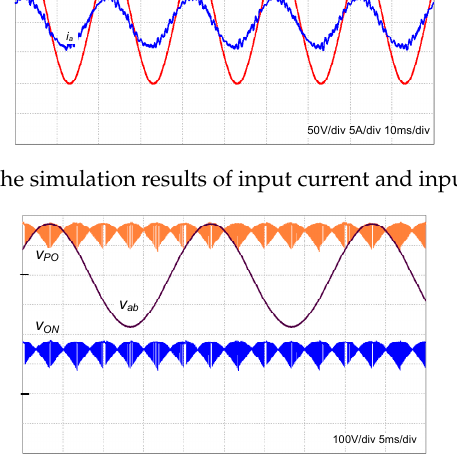
Figure 9. The simulation results of DC-link voltage V PO and V ON , which are generated by the upper and lower rectifiers, respectively.